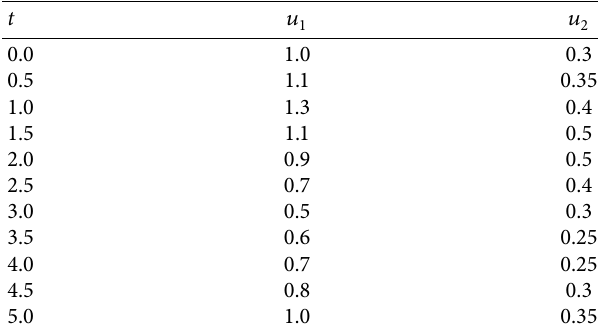
Table 5: Measurement taken at discrete points Example 3.